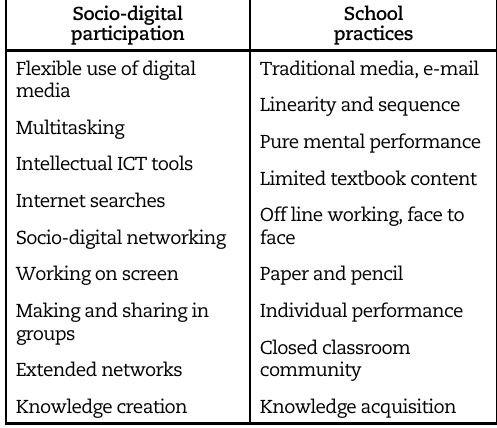
Table 1: Digital Generation’s participatory models